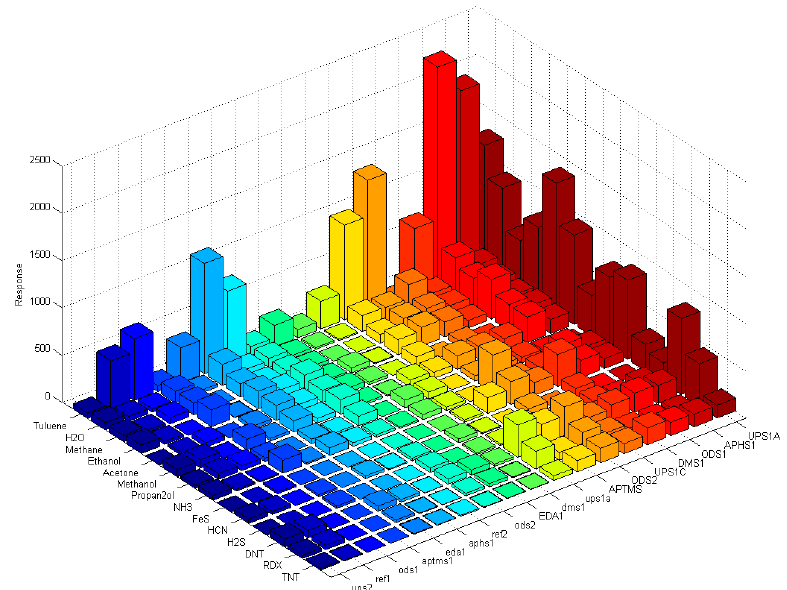
Figure 18. The complete matrix of absolute values of responses of differently functionalized sensors to different vapour traces. Each row on y-axis corresponds to modification layer; the bars are presented in different colour, so each colour presents one modification layer, while each column on x-axis corresponds to different vapour of the experiment. The height of each pixel represents relative response of particular sensor to the particular target molecule in the carrier gas. Sensors with lower case letters (i.e., ups1a) are the reference sensors where the modification layer is removed completely by laser treatment.